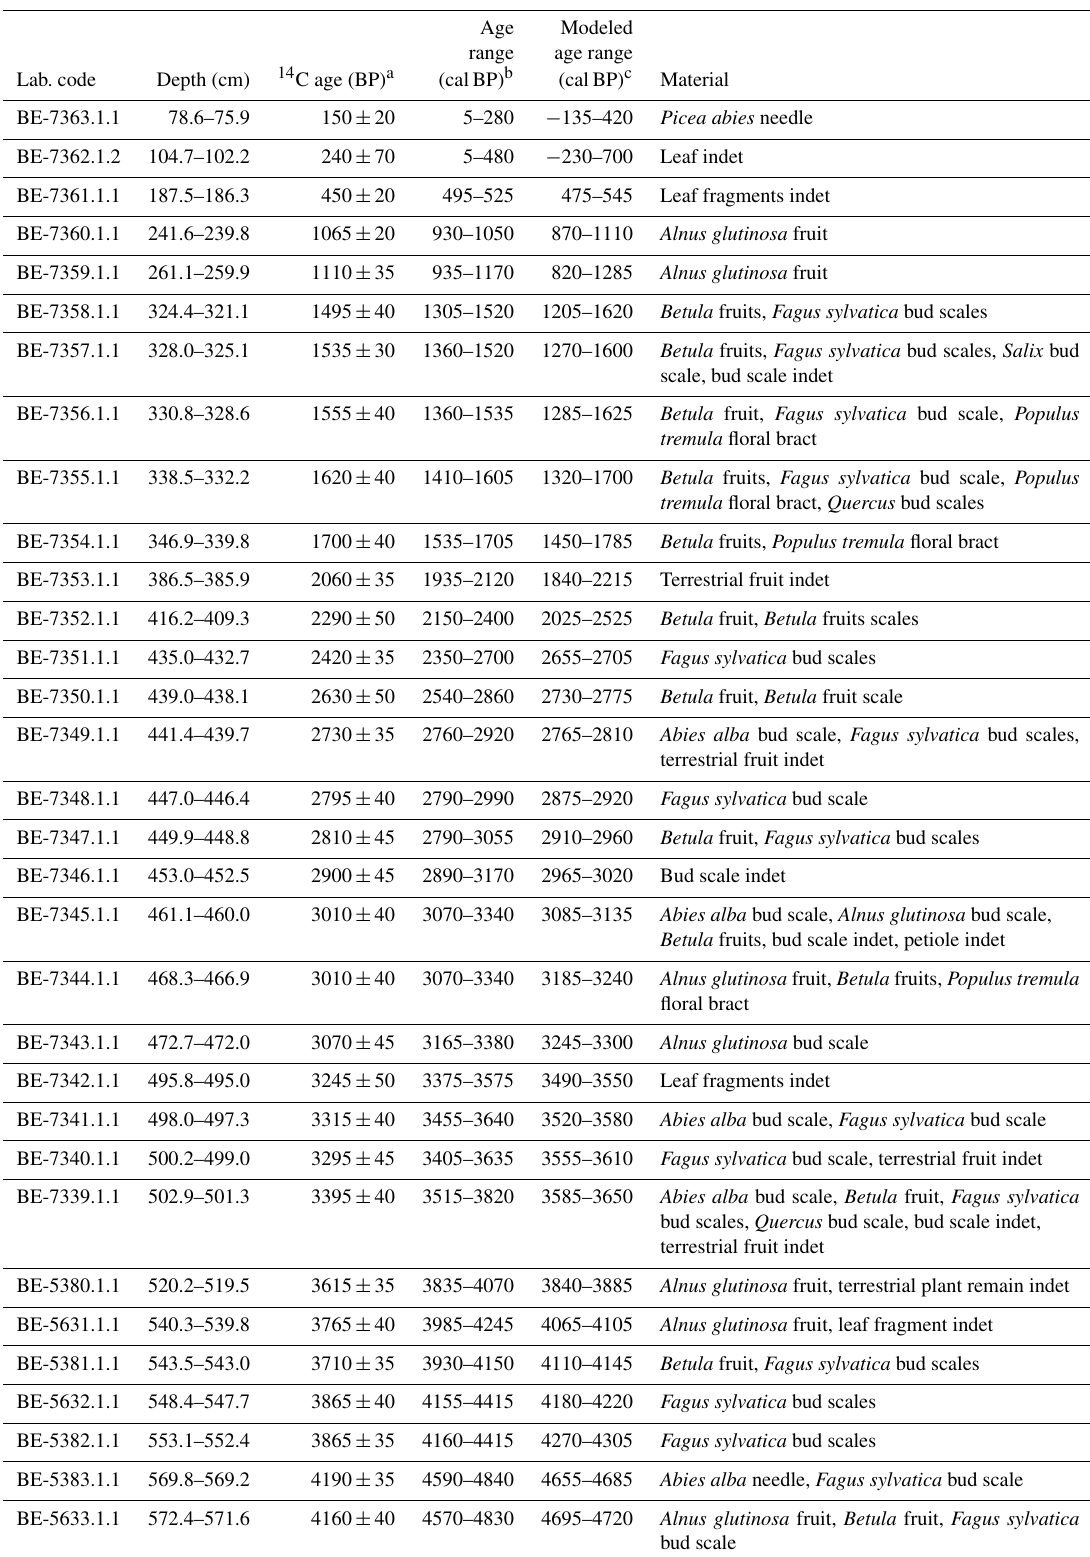
Table 1. Radiocarbon dates and calibrated ages from the Moossee record. Uncertainties in 14 C ages refer to 68% probabilities (1 σ ), whereas ranges of calibrated and modeled ages represent 95% probabilities (2 σ ). Indet: